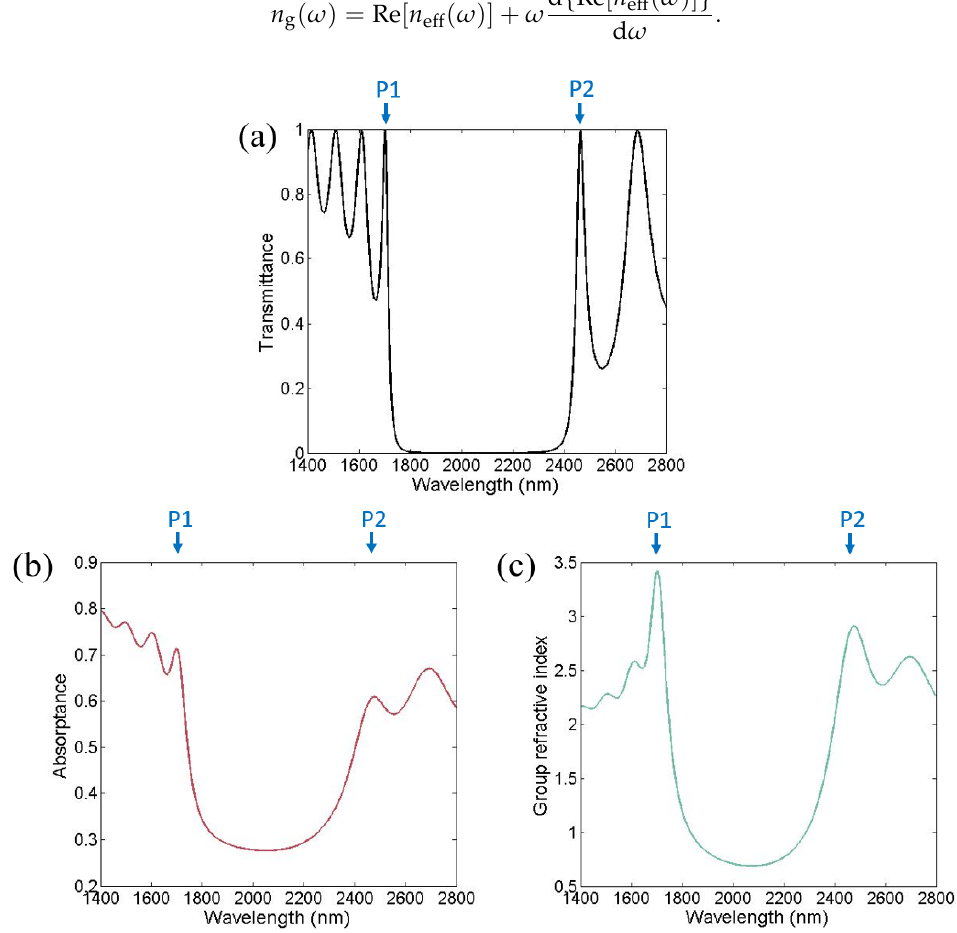
Figure 1. ( a ) Transmittance spectrum of the lossless all-dielectric 1-D PC (AB) 10 at normal incidence under TM polarization. ( b ) Absorptance and ( c ) group refractive index spectra of the lossy all-dielectric 1-D PC (AB) 10 at normal incidence under TM polarization.